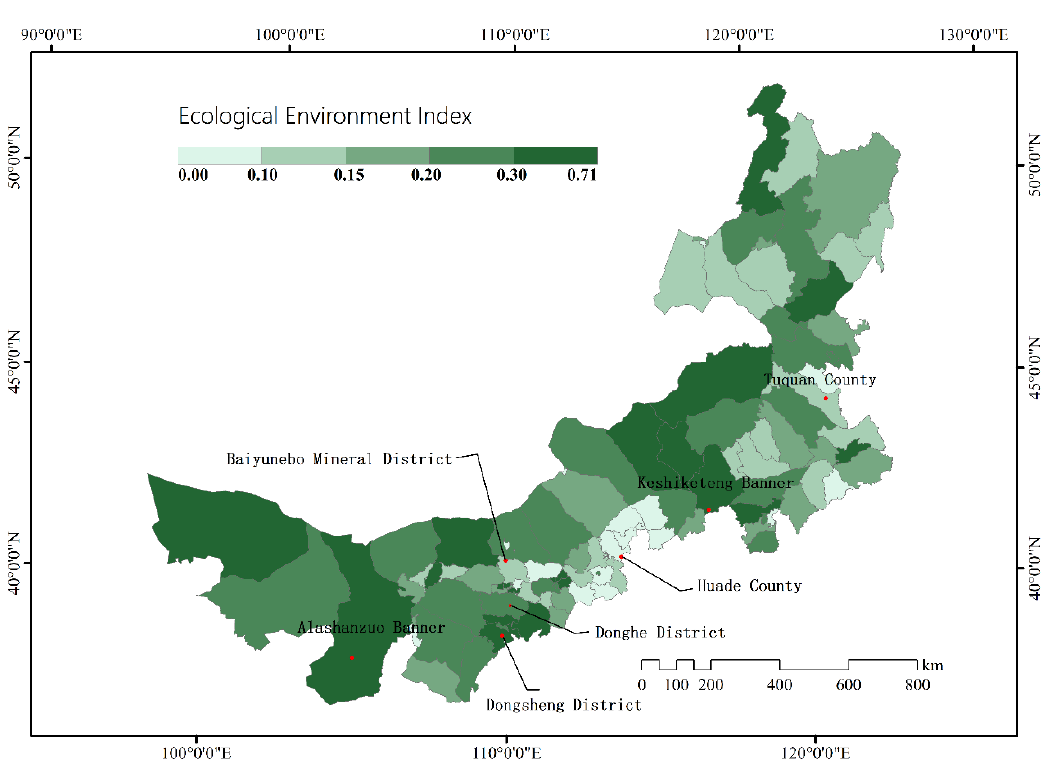
Figure 1. Spatial distribution of the ecological environment index in Inner Mongolia in 2020. ISPRS Int. J. Geo-Inf. 2021 , 10 , x FOR PEER REVIEW